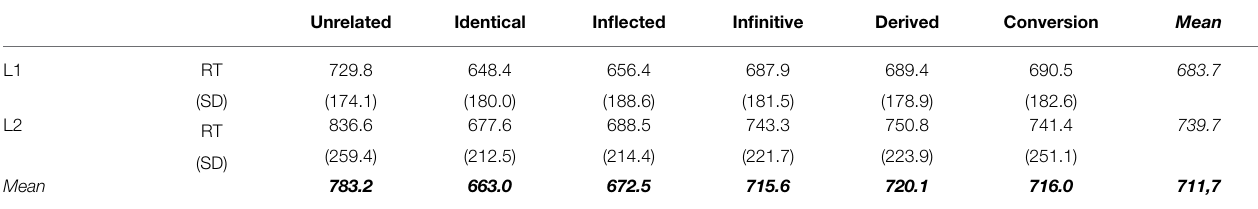
TABLE 6 | Experiment 3: mean reaction times for target phrases in ms, standard deviations (in